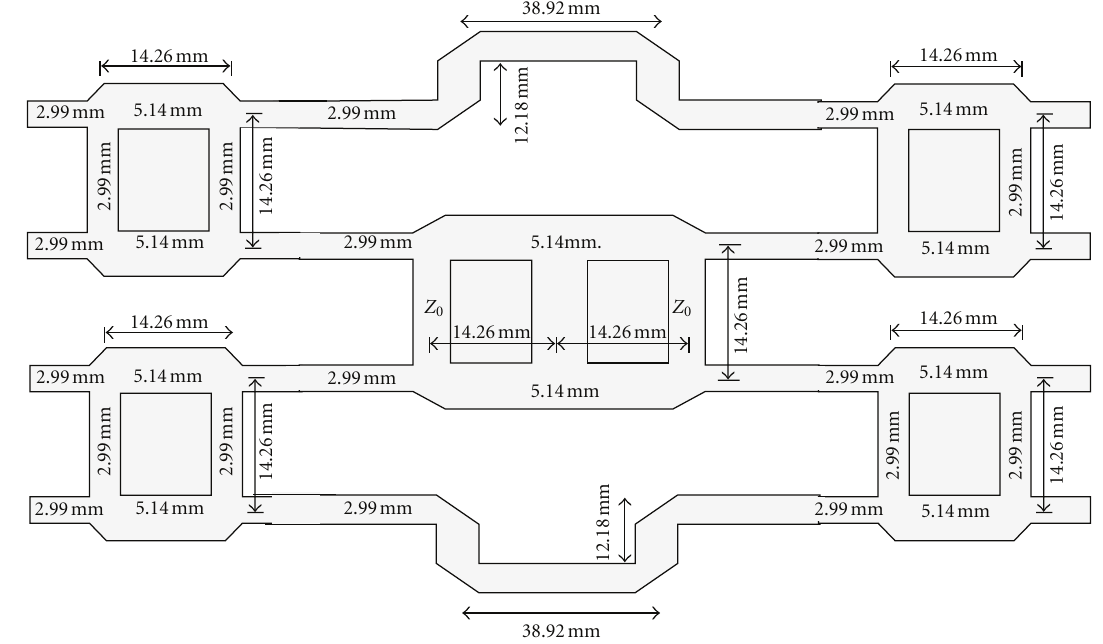
Figure 4: The dimensions of Butler matrix.